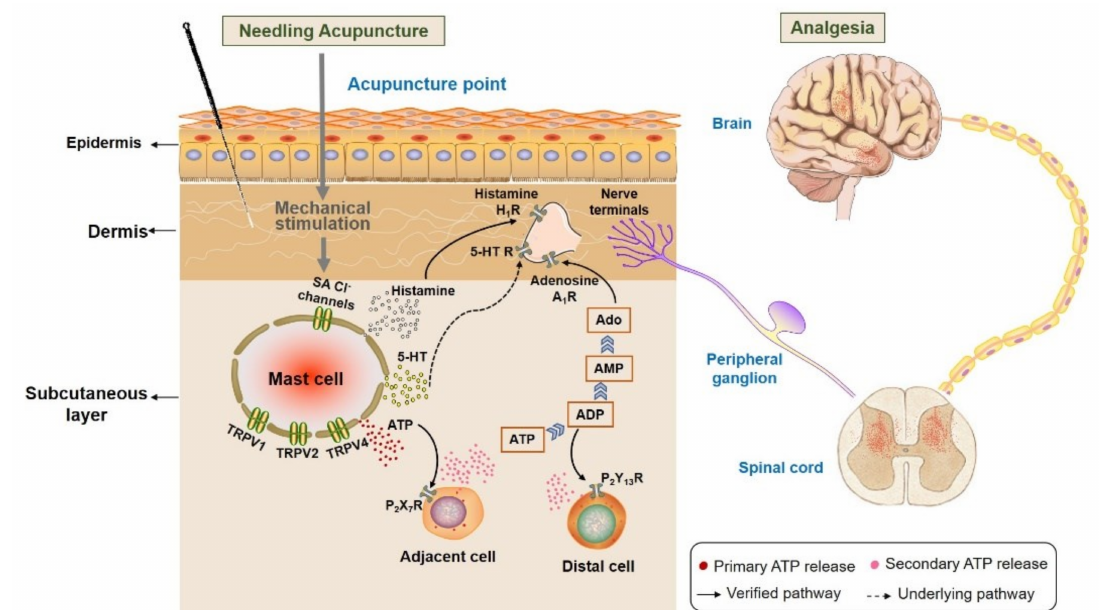
Figure 20. Activation of subcutaneous MCs triggers acupuncture analgesic effect. Needling acupunc- ture introduces physical stimuli to the treated acupoints. Subcutaneous MCs are activated to release various biological substances, including histamine, serotonin (5-HT) and ATP, through activating mechanosensitive channels. Subsequently, these substances or their downstream products bind to the corresponding receptors situated at local nerve terminals, or they mediate other cells to release ATP to amplify the local biochemical signals. Eventually, peripheral nerve endings ascend acupuncture signals to the peripheral ganglia, then to the spinal cord or upper spinal cord to generate